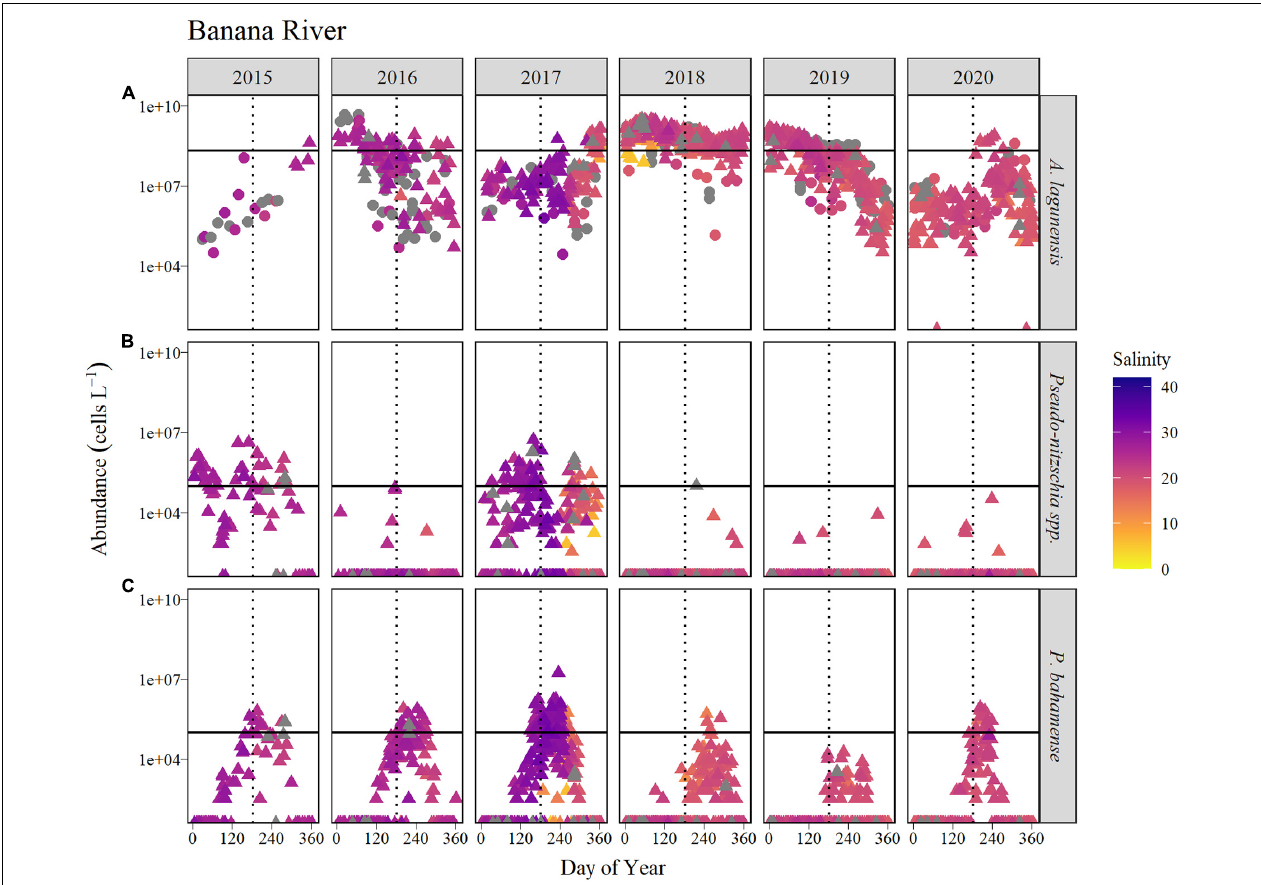
FIGURE 4 | Time course of abundance of (A) A. lagunensis cells, (B) Pseudo-nitzschia spp., and (C) P. bahamense presented on a logarithmic scale for the Banana River Lagoon sub-basin for the years 2015 to 2020 (horizontal panels). Symbol color indicates salinity in corresponding discrete samples, shown as a gradient from the lowest salinities (orange) to the highest (blue). Gray symbols represent samples in which no discrete salinity was recorded. For A. lagunensis , abundance was determined by FWC-FWRI microscopic enumeration (filled triangles) and immunofluorescence flow cytometry (filled circles). The solid horizontal line indicates the bloom levels for each taxon ( A. lagunensis = 2 × 10 8 cells L − 1 , Pseudo-nitzschia spp. and P. bahamense = 10 5 cells L − 1 ). The vertical dotted line represents JD 182 (July 1, non-leap